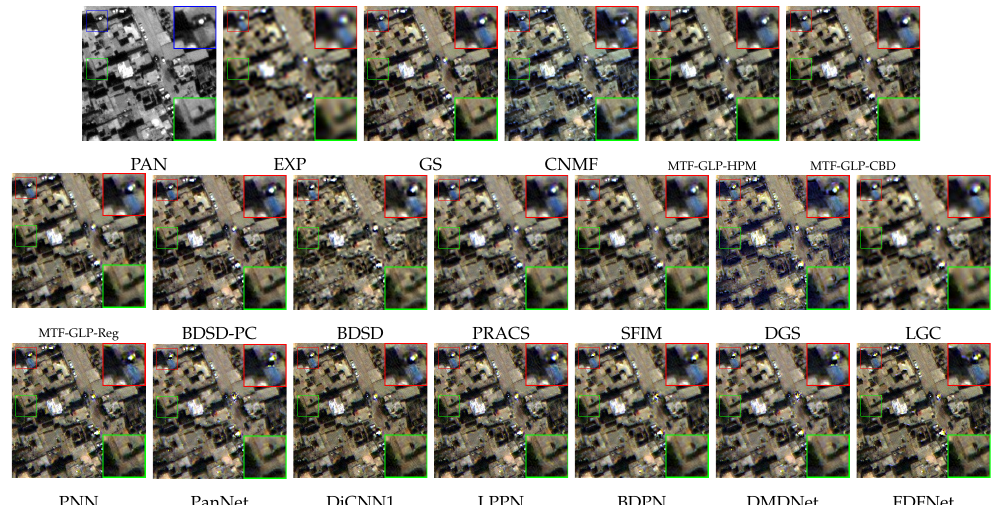
Figure 12. The visual comparisons on a full-resolution WorldView-3 case (shown by bands: 1, 3, and 5).